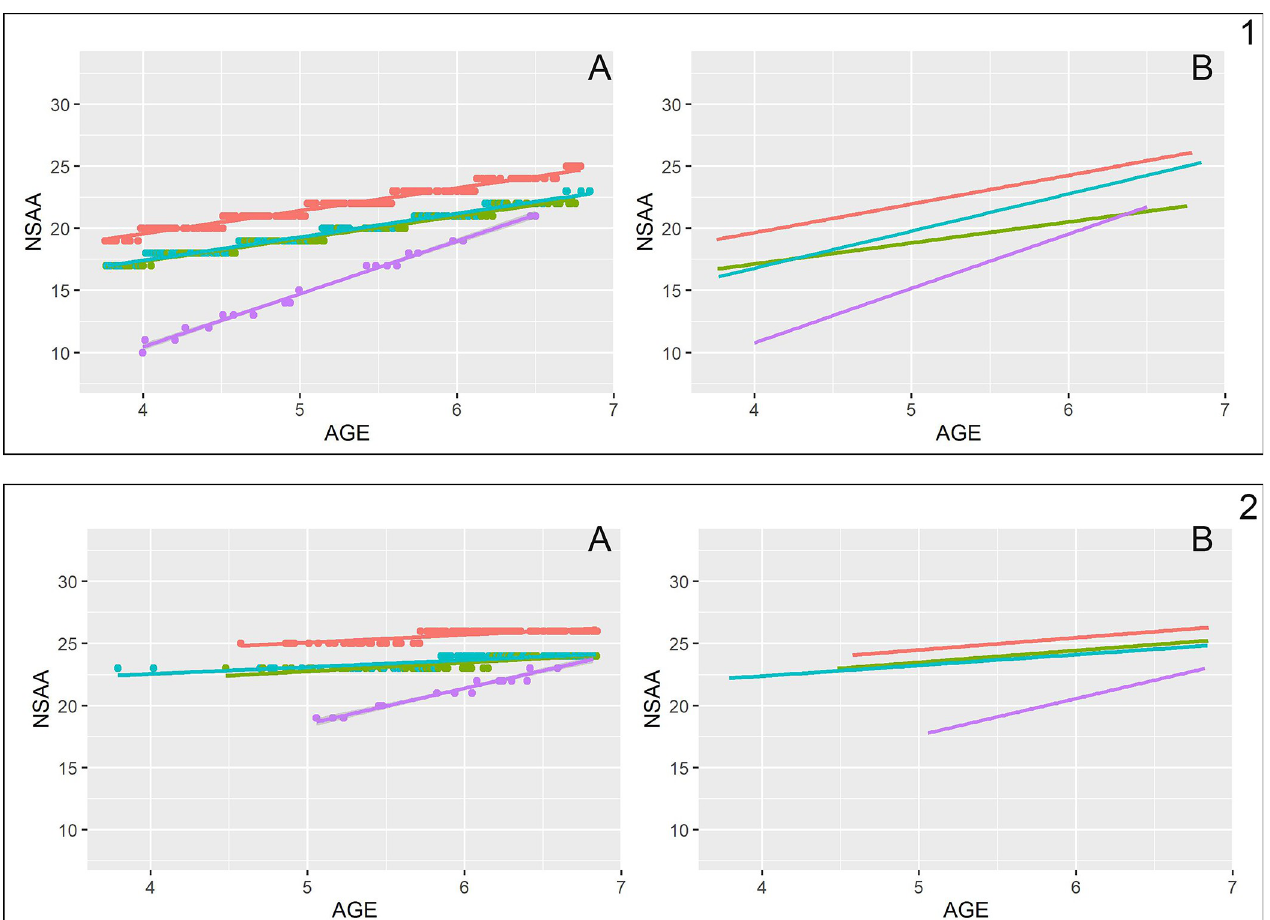
Fig 3. Linear fit on modeled vs real data by brain dystrophin involvement and corticosteroid status. Key to figure: Panel 1 = Patients on CS treatment on less than 6 months/naive, (A) modeled (B) real; Panel 2 = Patients on CS treatment on less from more than 6 months, (A) modeled (B) real. Color coding: Red = Dp427, green = Equivocal, blue = Dp140, purple =